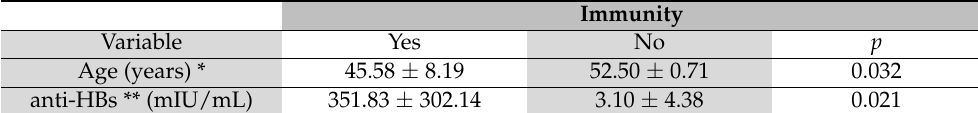
Table 1. Correlation between immunity, age, and antibody titer ( n =